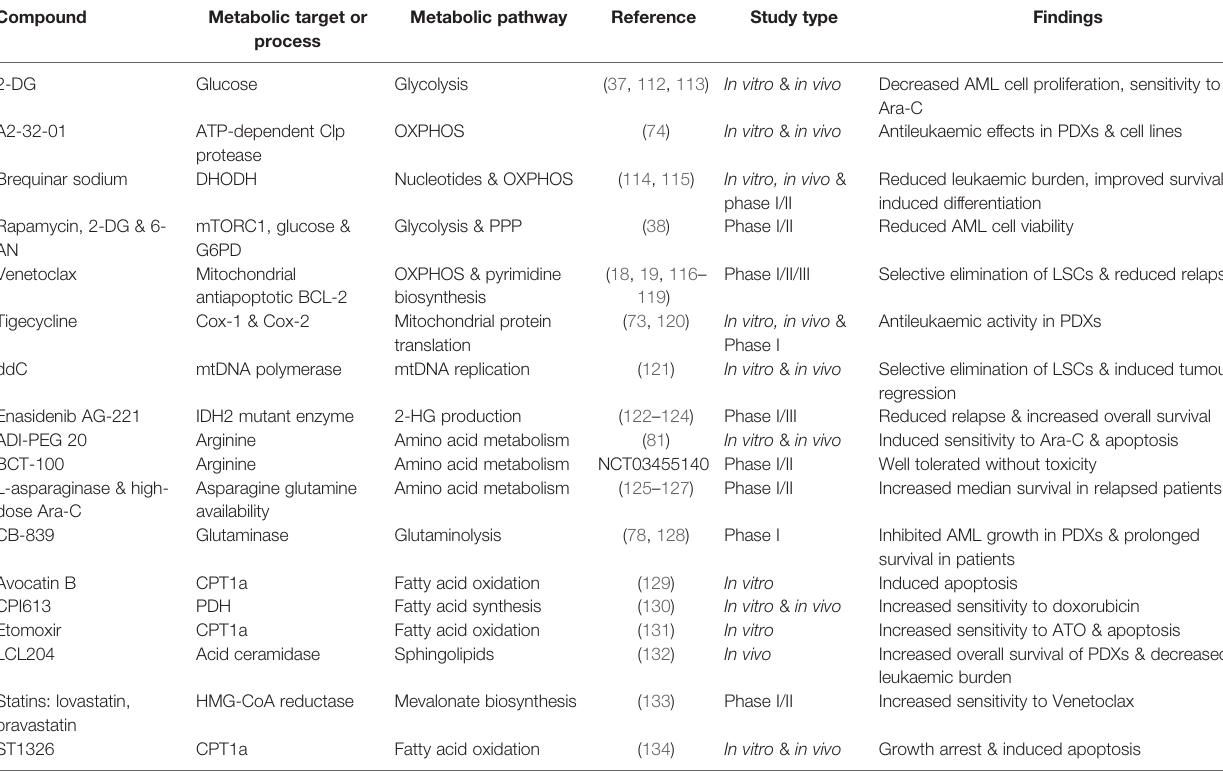
TABLE 1 | Modulators of metabolic pathways, preclinical studies, and clinical trials in AML.